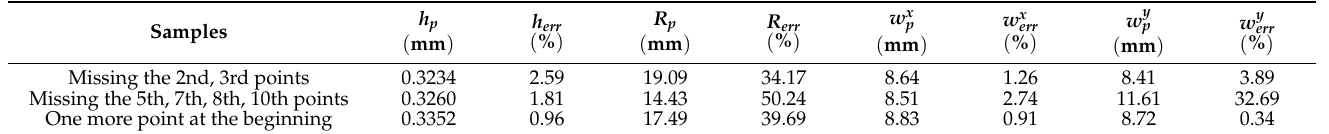
Table 8. The parameters of the predicted surface of the three examples.